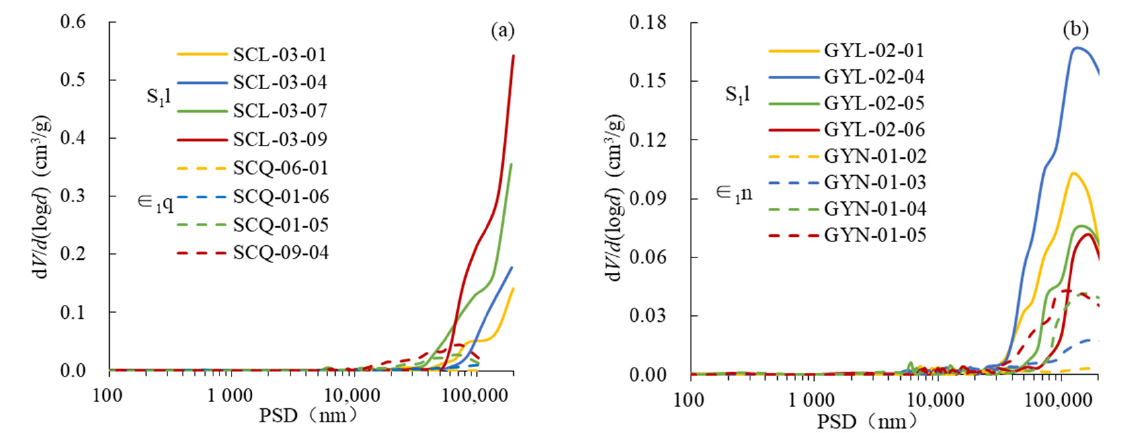
Figure 9. PSD curves of the Lower Paleozoic shales based on the HMIP in southern Sichuan Basin ( a ) and northern Guizhou province ( b ). (S 1 1 = the Lower Silurian Longmaxi Fm, ∈ 1 q = the Lower Cambrian Qiongzhusi Fm, ∈ 1 n = the Lower Cambrian Niutitang Fm).